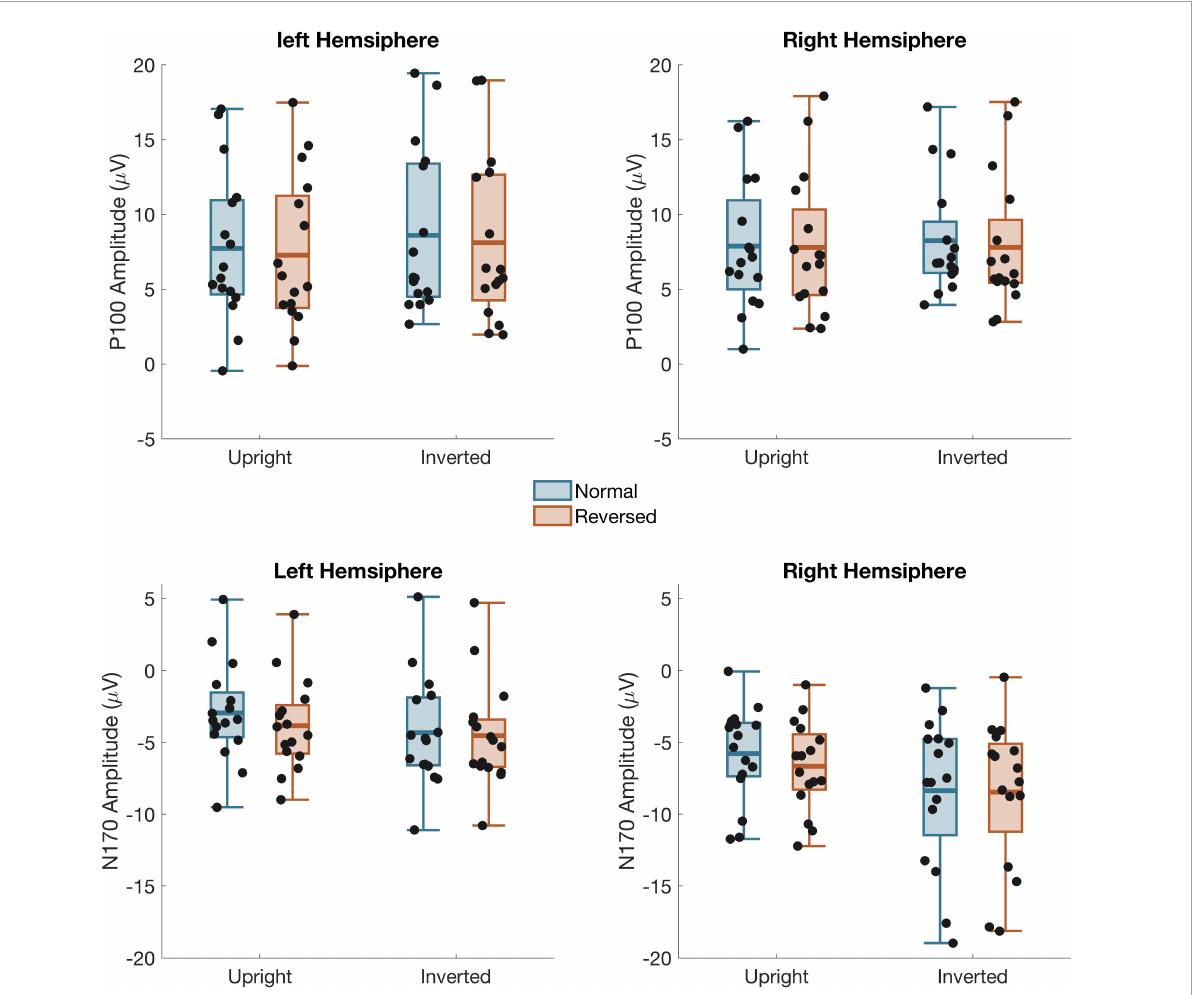
FIGURE3 Mean amplitude from left and right hemisphere channel groups for the P100 (top) and N170 (bottom) time windows Black dots: individual subject data. Box shows the mean and first and third quartile. The whiskers show the 2nd to 9th